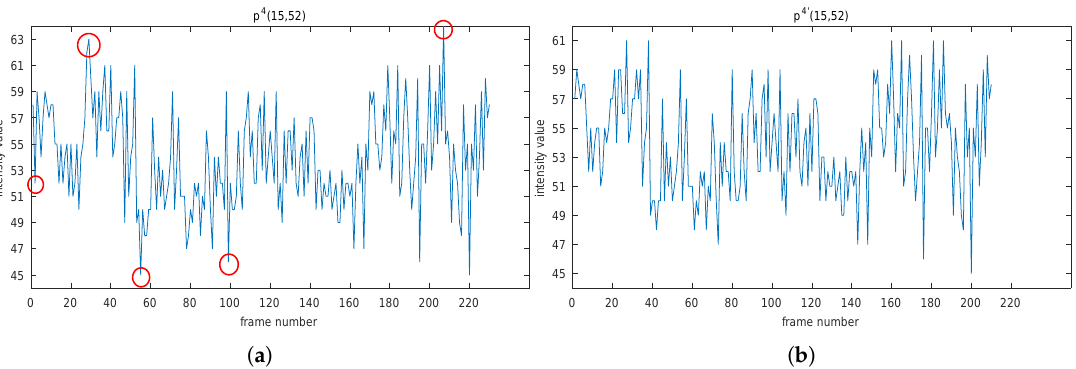
Figure 6. Distributions of p 4 presented in ( a , b ) are before and after using NoIV-1, respectively. Red circles in (a) remind about the disappearance of noises compared with